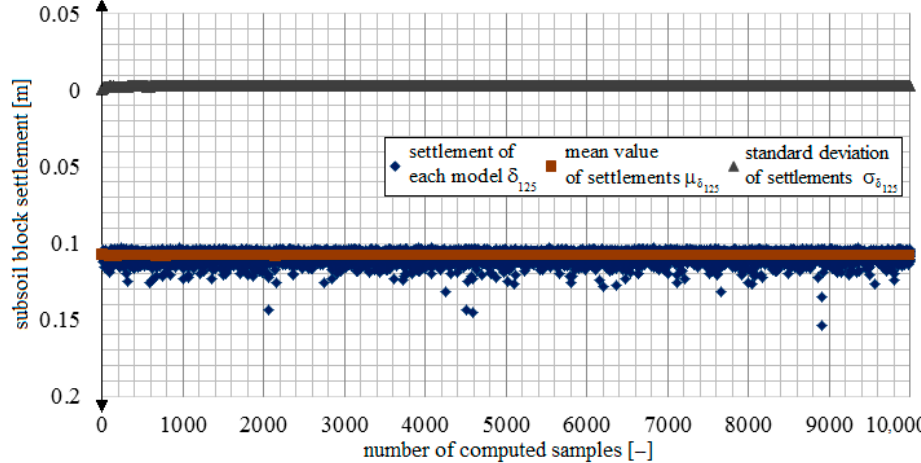
Figure 11. Convergence of simulation-based settlement estimation; the Monte Carlo FE material model; 10,000 samples, = 125